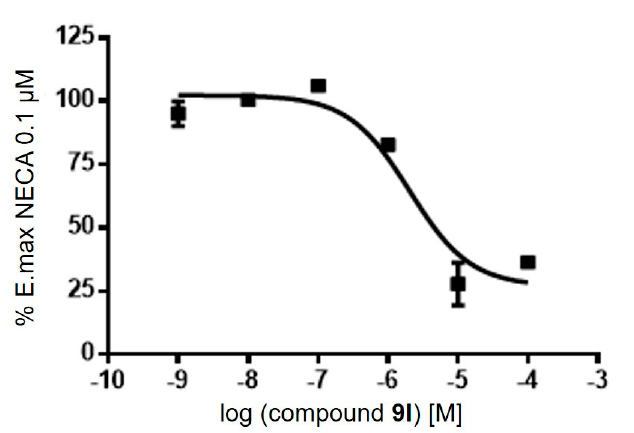
Figure 3. Concentration − response curve of 9l in a functional assay at human A 3 AR measuring inhibition of 10 µ M NECA-induced cAMP accumulation. Points represent mean ± SD (vertical bars) of duplicate experiments.